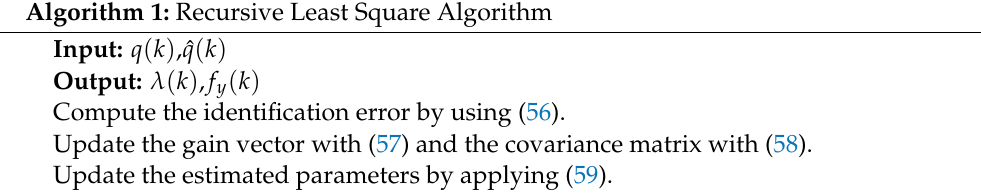
Algorithm 1: Recursive Least Square